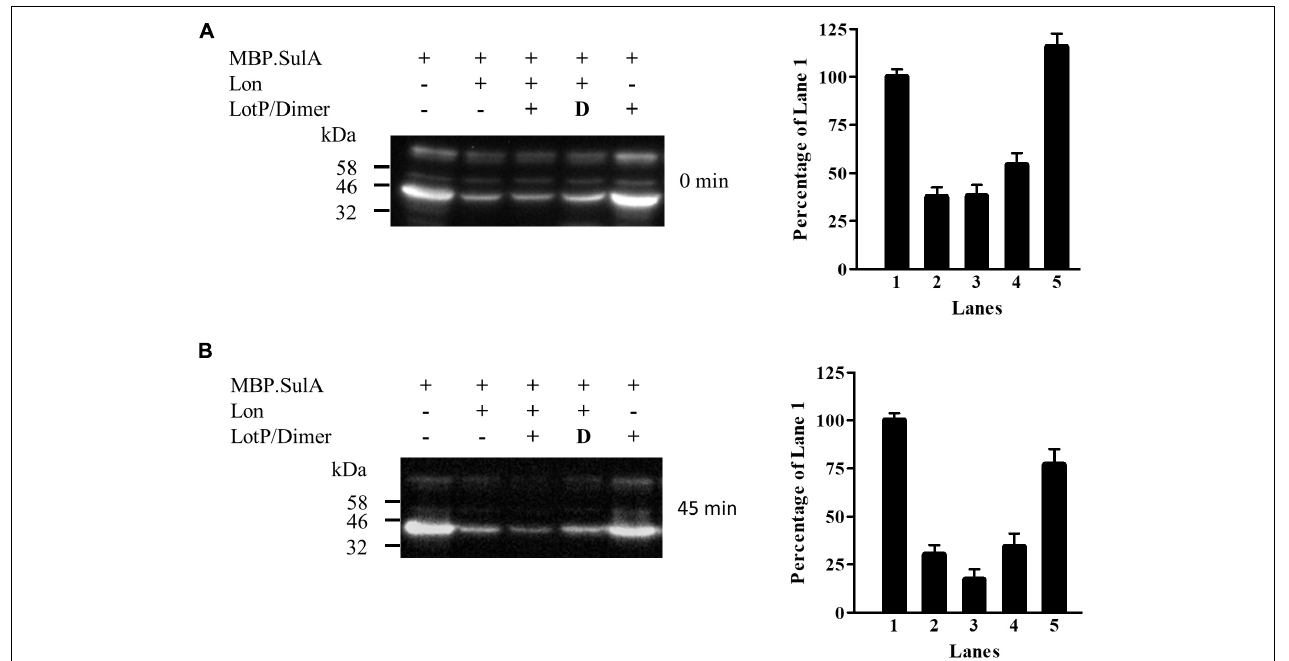
FIGURE 8 | LotP increases the degradation of MBP.SulA in Escherichia coli . Western blotting using anti-FLAG antibodies of samples taken from E. coli overexpressing His.LotP, His.EK.LotP, Lon, and MBP.SulA (MBP.SulA has a FLAG tag in the N-terminal). After 30-min induction antibiotics was added to stop protein synthesis. Degradation was followed at 0 min (A) and 45 min (B) post incubation and phenylmethylsulfonyl fluoride (PMSF) added to halt degradation. The assay was done in duplicate, while a representative figure is shown in the left panels. The right panels show the quantification of the Western blotting bands. Columns were normalized to lane